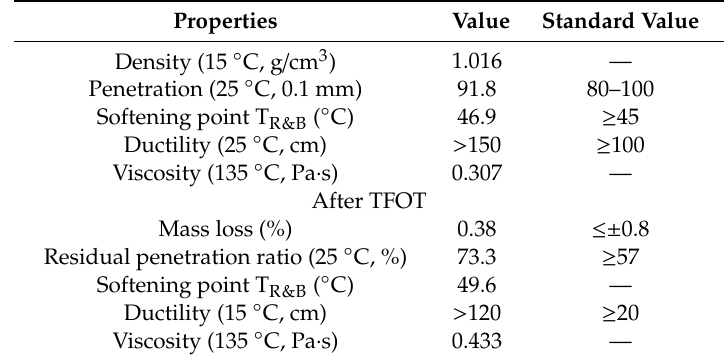
Table 1. Physical properties of matrix asphalt.